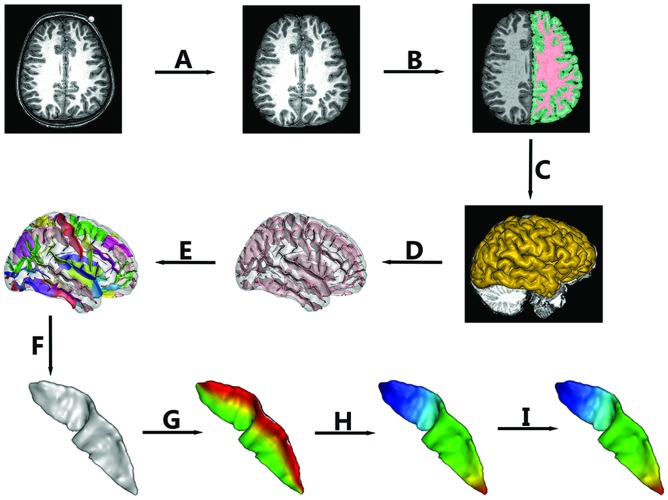
The pipeline of central sulcus (CS) extraction and parameterization. Extraction of CS consisted of the following steps: (A) Skull stripping; (B) Spatial normalization, RF homogeneity correction, and tissue segmentation; (C) Extraction of gray matter (GM)/cerebrospinal fluid (CSF) surfaces; (D) Extraction of sulcal folds; (E) Automated labeling of sulci; (F) Manual verification of the CS. Sulcal parameterization included three steps: (G) Parameterization along the x coordinate; (H) Parameterization along the y coordinate; (I) Reparameterization by rescaling the y coordinate.